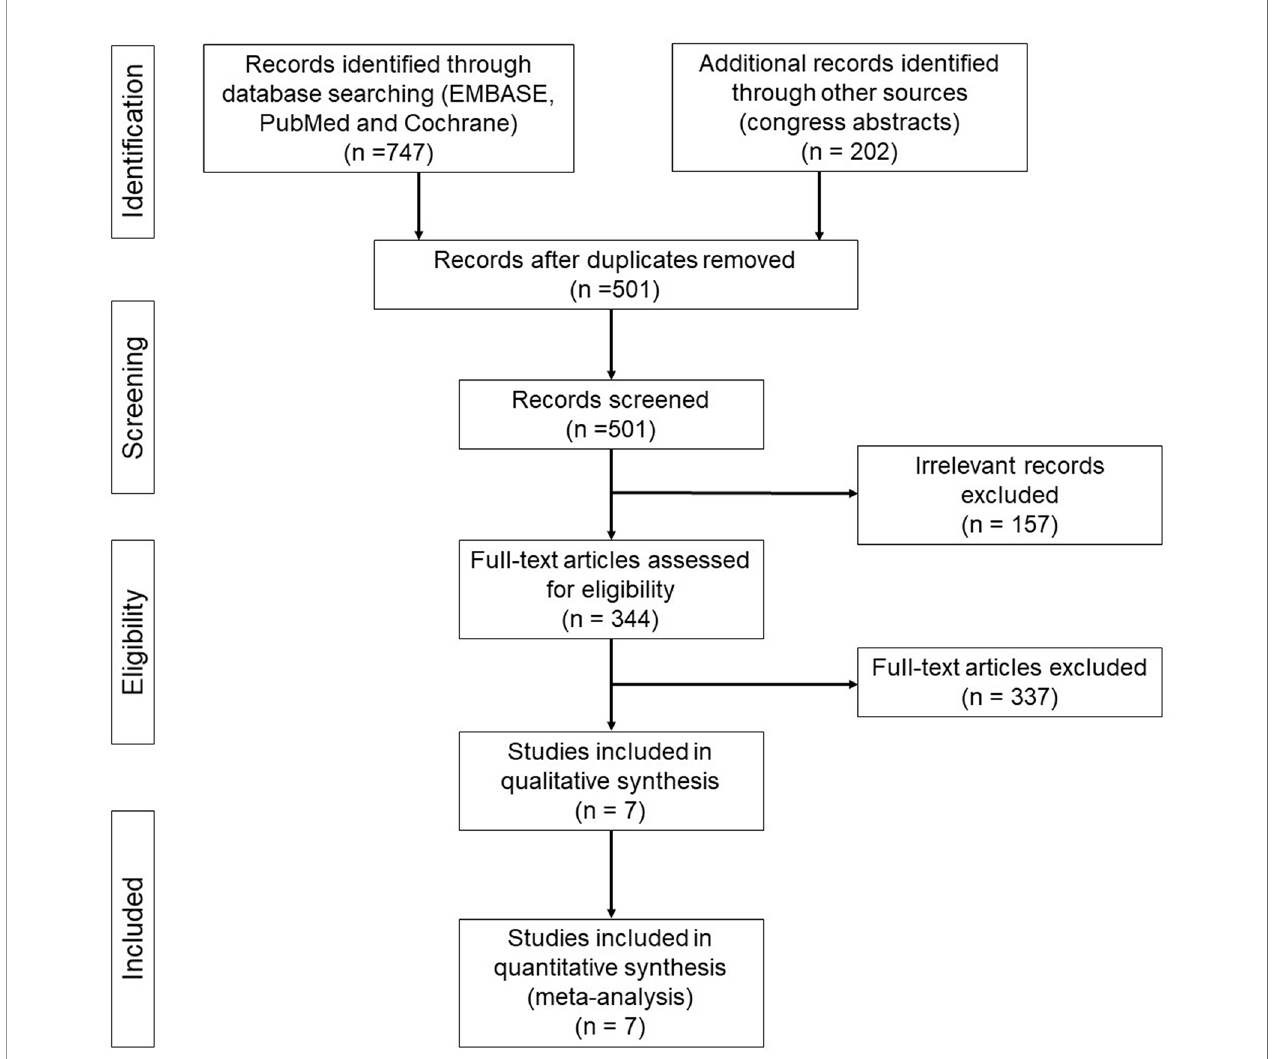
FIGURE 1 | PRISMA fl ow diagram of randomized phase III clinical trials of next-generation ALKIs as fi rst line treatment for advanced ALK-positive